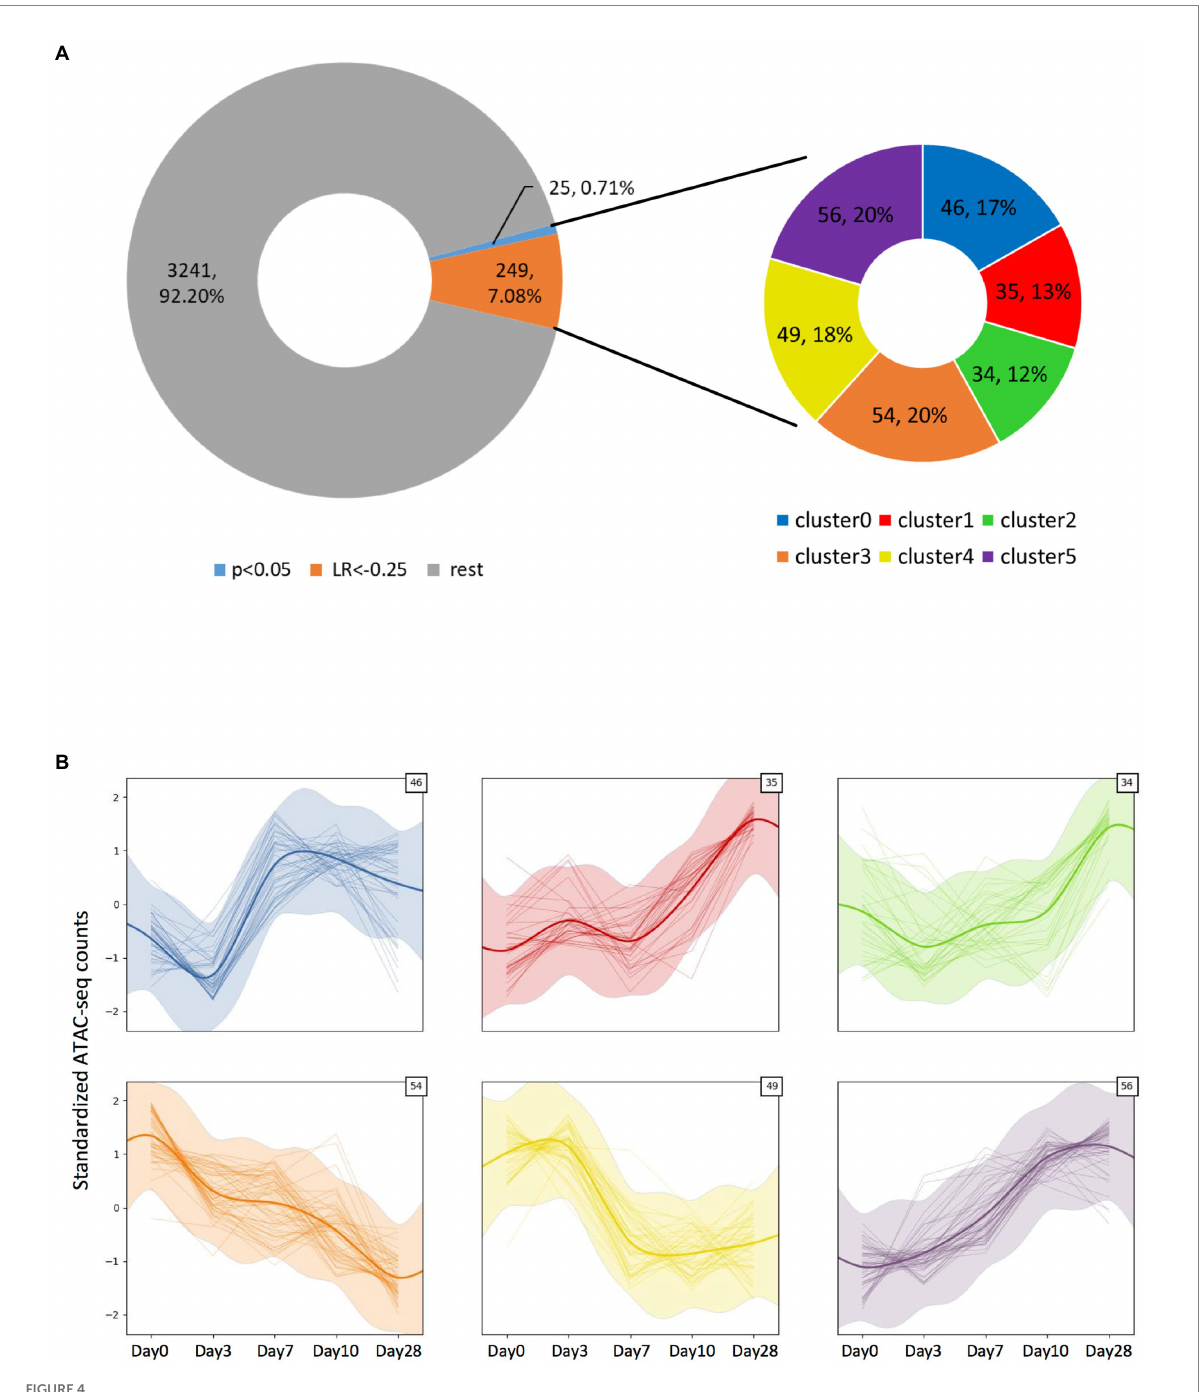
FIGURE 4 Identification of the ATAC-seq peaks displaying temporal dynamics. (A) Doughnut chart representing all significant peaks observed from the ATAC- seq assay. Among them, a small fraction displays significant (value of p > 0.05) temporal dynamics as defined by a Gaussian process mixture model, but by applying a log-likelihood ratio-based criteria with LR < − 0.25, ~7.8% of the peaks could be considered to have dynamic behavior. The dynamic peaks could be clustered into six categories, depending on their specific dynamic behavior. (B) Plots showing each category’s dynamic behavior defined by the Gaussian process mixture model mean and SD (represented by the thick smoothed line and shaded ribbon), as well as each clustered peak count value across time (thin lines). The number on the top-right corner indicates the number of peaks included in each